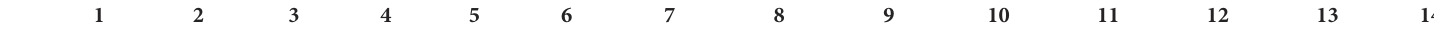
TABLE 1 Pearson’s correlation coefficients and descriptive statistics for the main variables in the study ( N = 169) + .